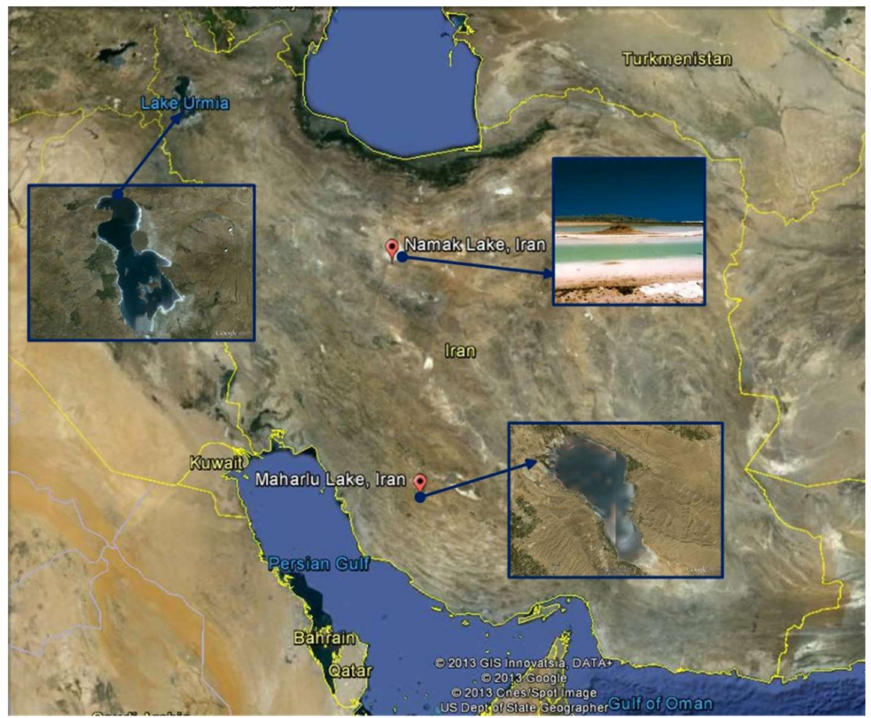
Figure 4. The location of the Urmia, Maharlu, and Namak Lakes in